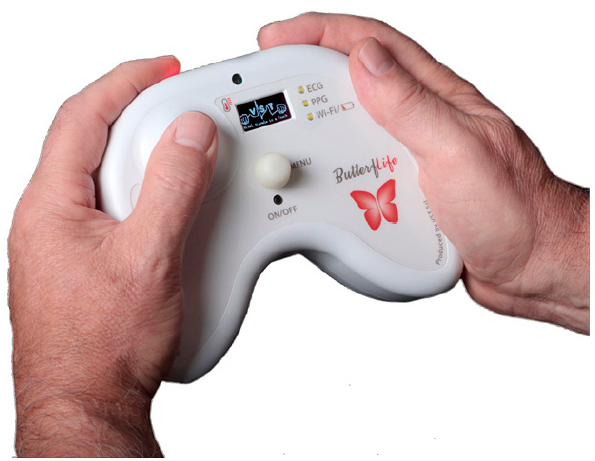
Figure 2. ButterfLife medical